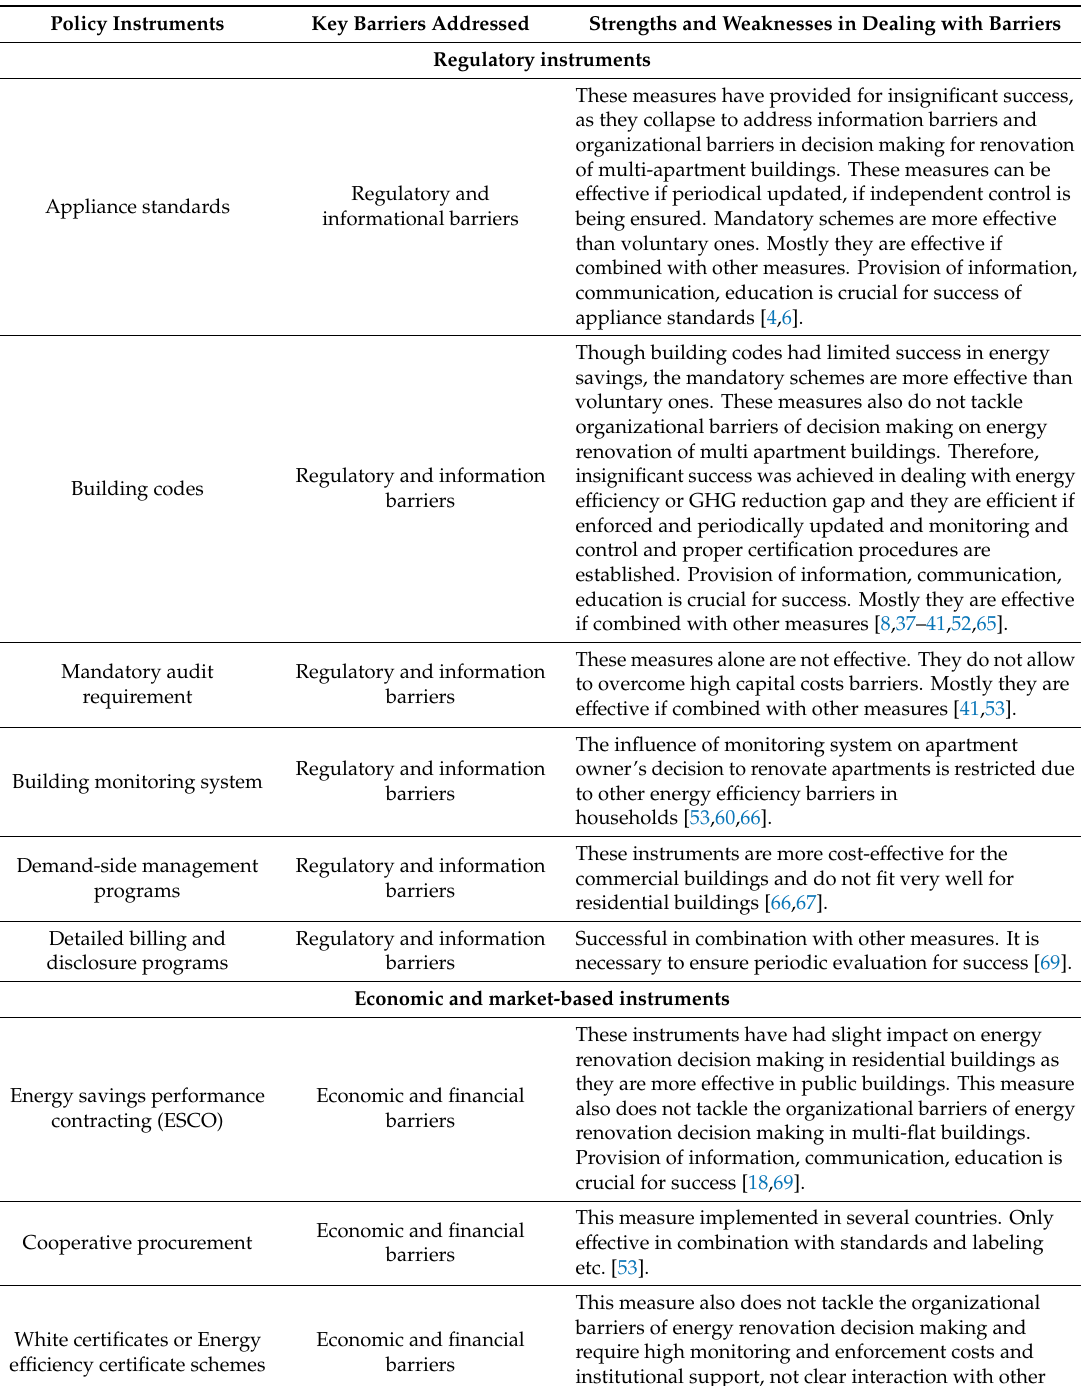
Table 2. Assessment of strengths and weaknesses of policies and measures in dealing with main barriers of energy e ffi ciency improvements in